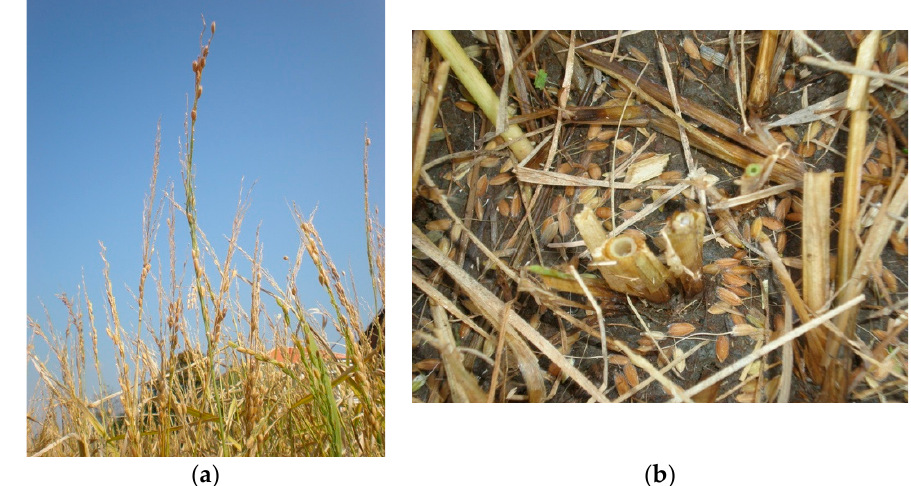
Figure 3. ( a ) Weedy rice panicles with several shattered seeds ( b ) Shattered weedy rice seeds lying on the soil surface.